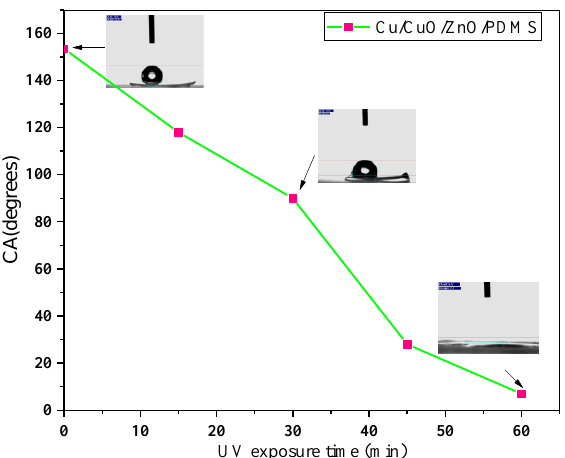
Figure 10. Water contact angle as a function of the UV irradiation time for the Cu/CuO/ZnO/PDMS sample.